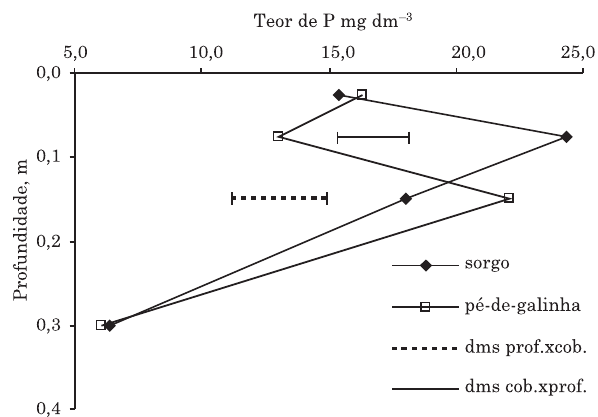
Figura 1. Teores médios de fósforo no solo em função da camada de solo amostrada e das culturas de cobertura em sistema plantio direto (dms = diferença mínima significativa, Tukey a 5